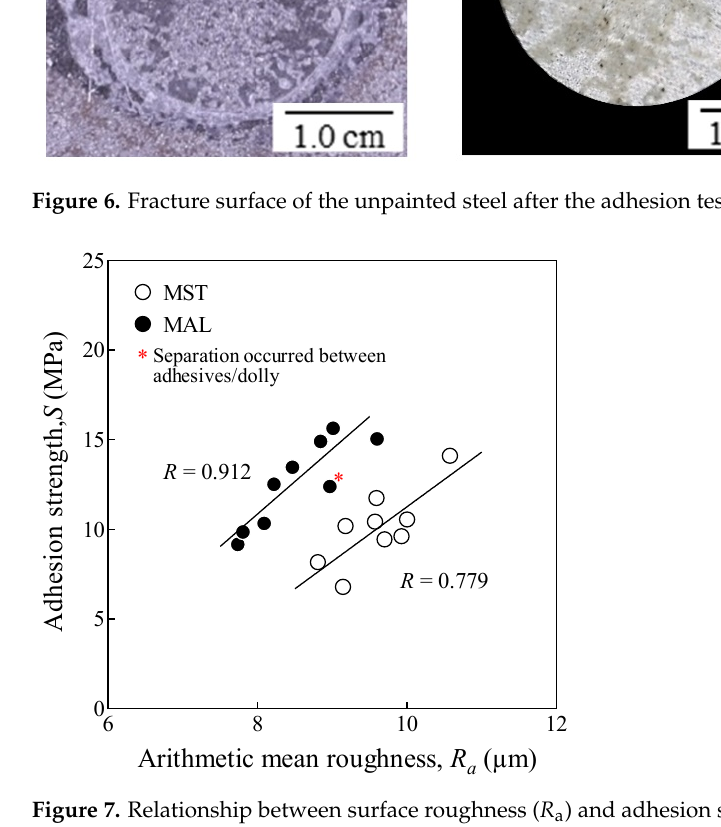
Figure 7. Relationship between surface roughness ( R a ) and adhesion strength.